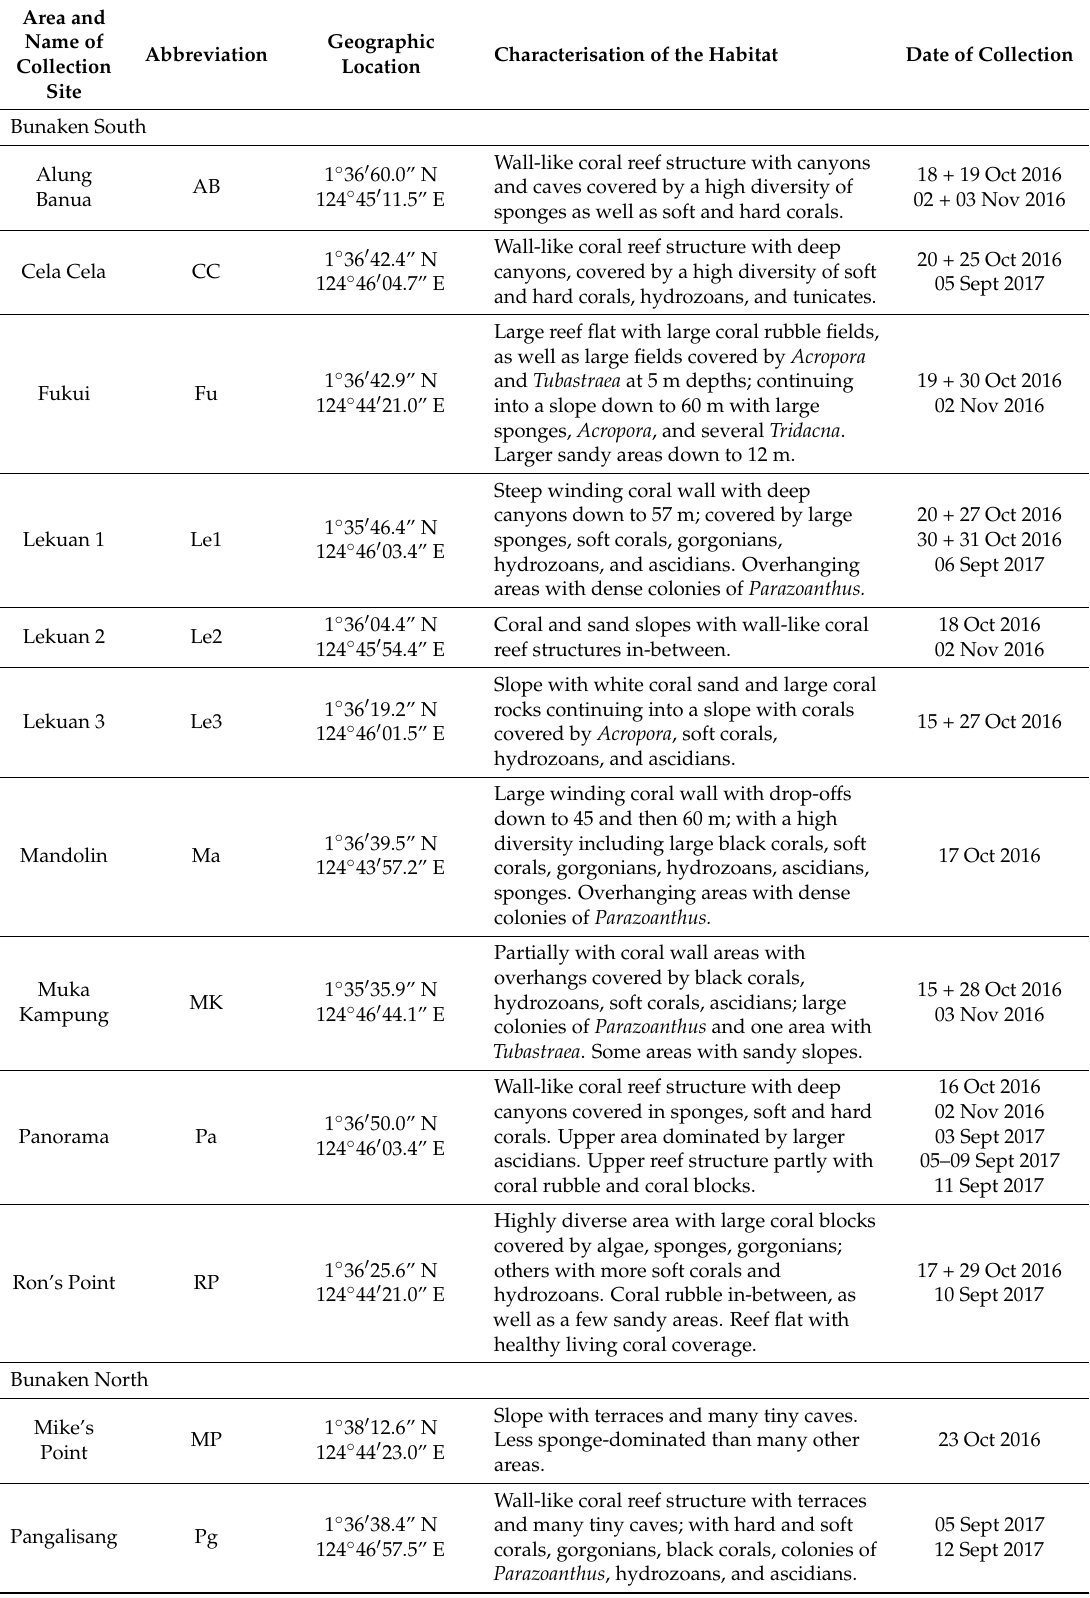
Table 1. Information about collection sites and dates of collections in 2016 and